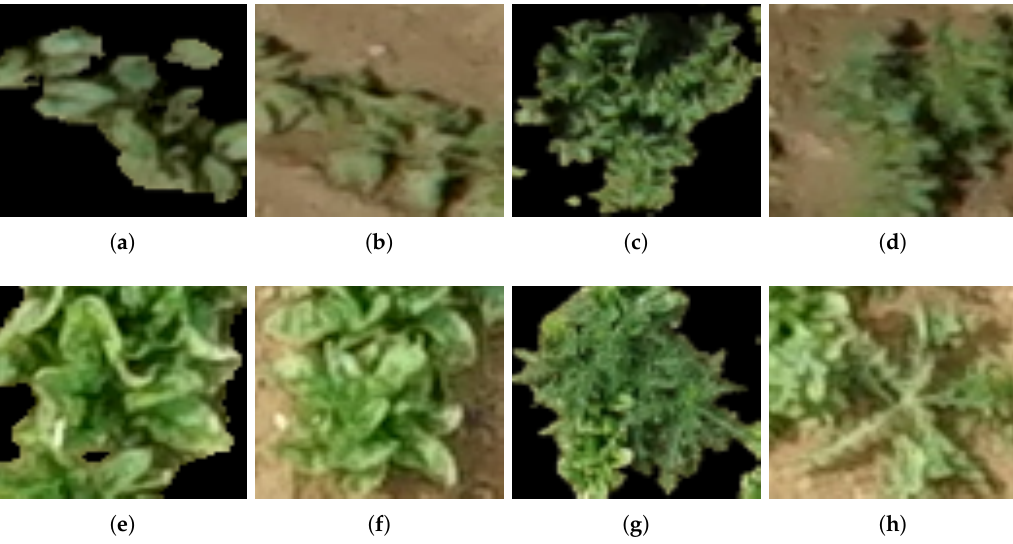
Figure 7. Example of crop and weed samples of size 64 × 64 pixels with and without background. Bean: samples of crop ( a , b ), samples of weed ( c , d ). Spinach: samples of crop ( e , f ) and samples of weed ( g , h ). Depending on the plant size and the window position, we obtain a plant or aggregation of plants per